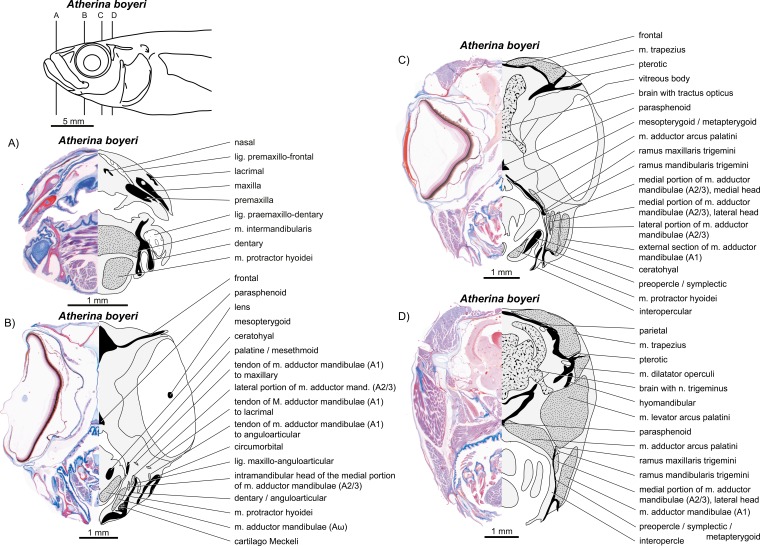
Atherina boyeri.(A–D) Histological sections; compare to Figs. 8 and 12D.